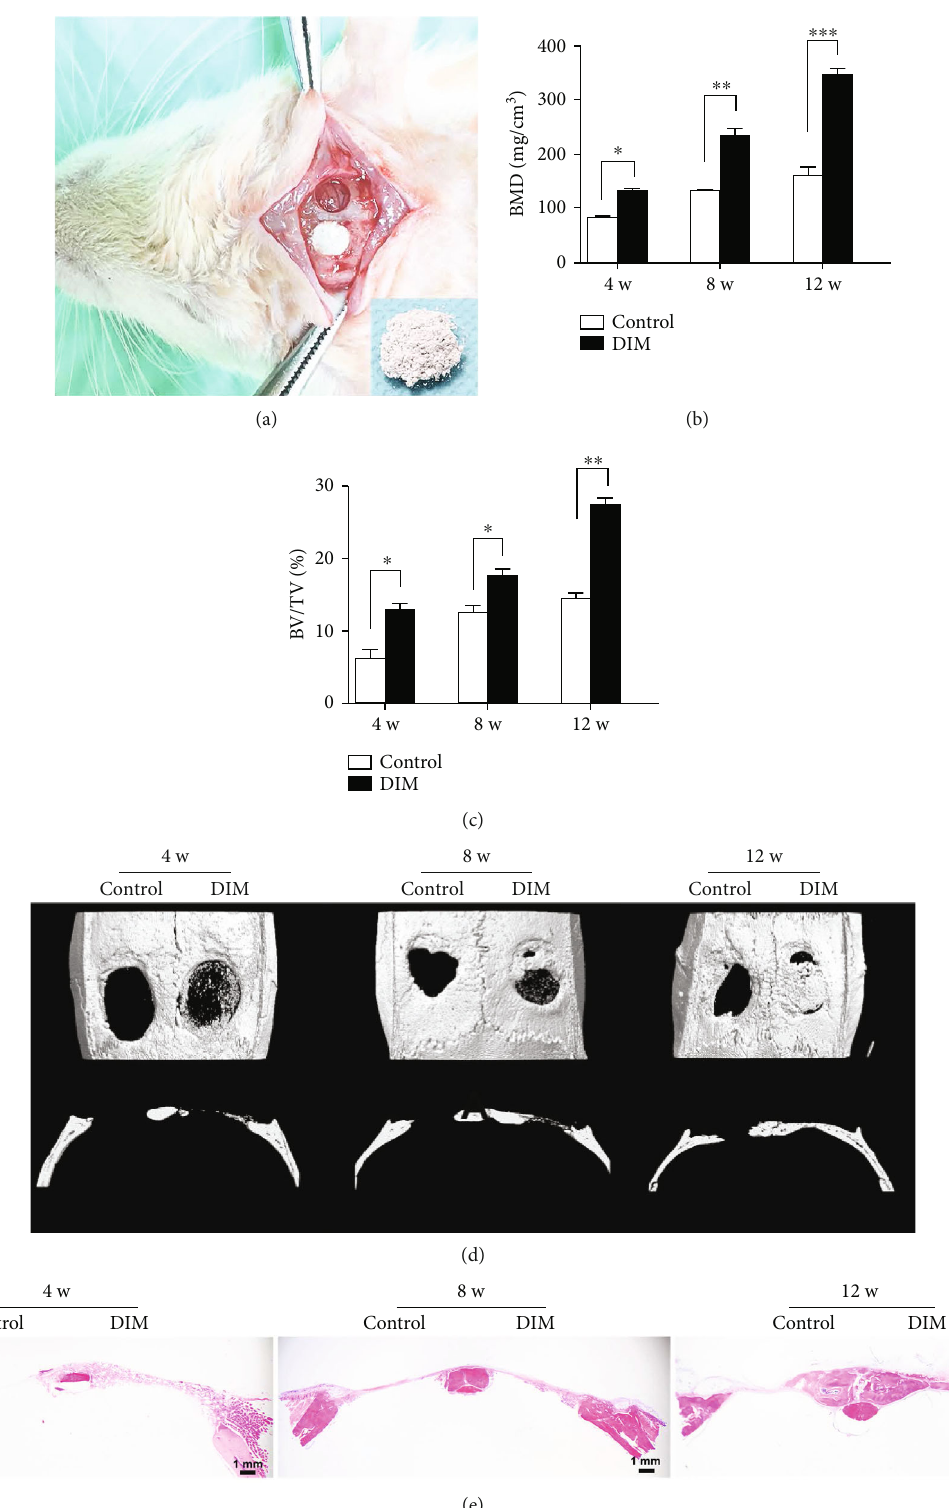
Figure 1: Micro-CT and H&E staining analysis of bone defects treated with DIM at 4, 8, and 12 weeks after surgery. (a) Image of a rat critical- sized calvarial defect model and DIM implantation. (b) Relative 3D reconstruction parameter BV/TV of newly formed bone by micro-CT. ∗ P < 0 : 05 , ∗∗ P < 0 : 01 , and ∗∗∗ P < 0 : 001 . (c) Relative 3D reconstruction parameter BMD of newly formed bone by micro-CT. ∗ P < 0 : 05 and ∗∗ P < 0 : 01 . (d) 3D reconstruction of calvarial defects and exemplary axial sections by micro-CT. (e) Representative coronal images of calvarial defects by H&E staining. Scale bars = 1 mm